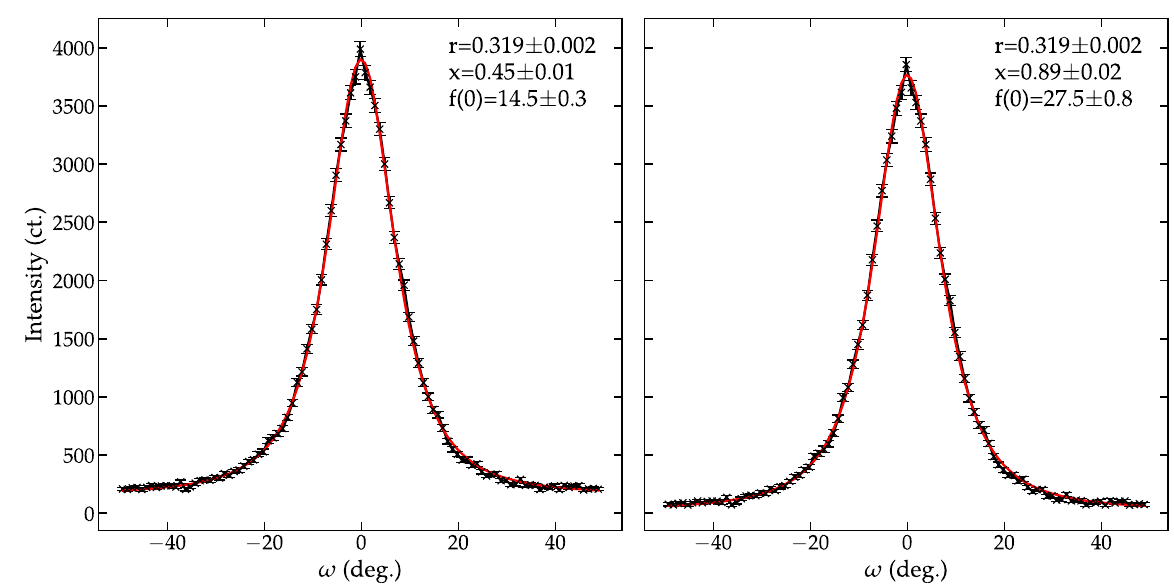
Figure 2. Measured 200 pole density of BNT-BT-KNN were of as measured ( left ) and background subtracted ( right ) BNT-BT-KNN (X) overlaid with a March–Dollase functional fit.